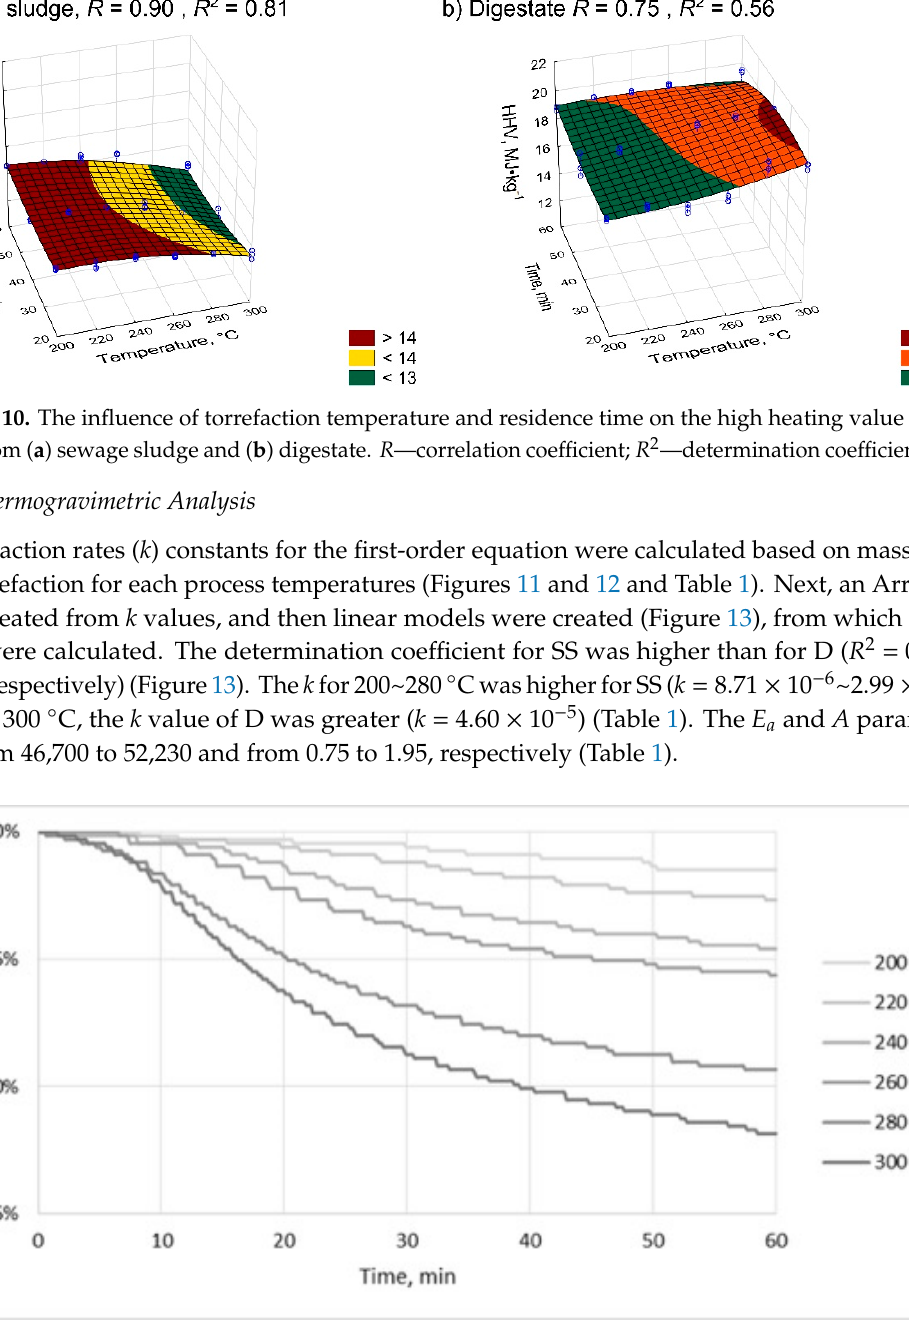
Figure 11. TGA of sewage sludge at torrefaction temperatures.